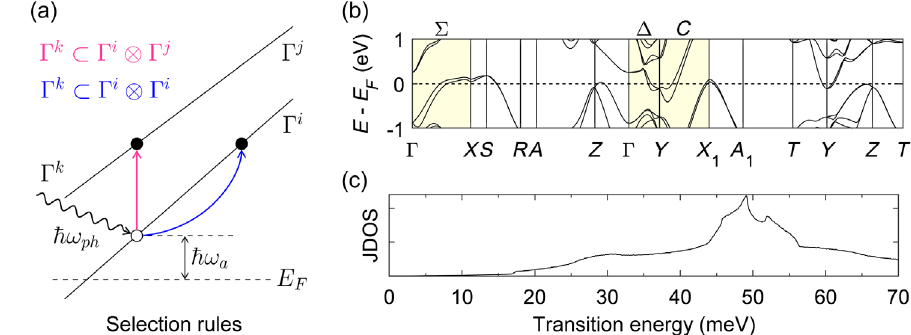
FIG. 3. (a) Schematic depicting interband (pink arrow) and intraband (blue arrow) transitions by optical phonons. An energy ℏ ω separates the initial electron state from the Fermi energy E . The electronic bands are labeled by irreducible representations Γ i and Γ j , F while the optical phonon of energy ℏ ω has the representation Γ k . (b) Calculated electronic band structure of WP 2 . The shaded regions ph indicate symmetry lines where scattering by Γ -point optical phonons is allowed and energetically possible. (c) Weighted joint density of states for vertical ( q ¼ 0 Þ transitions between states within (cid:2) 70 meV of E . F